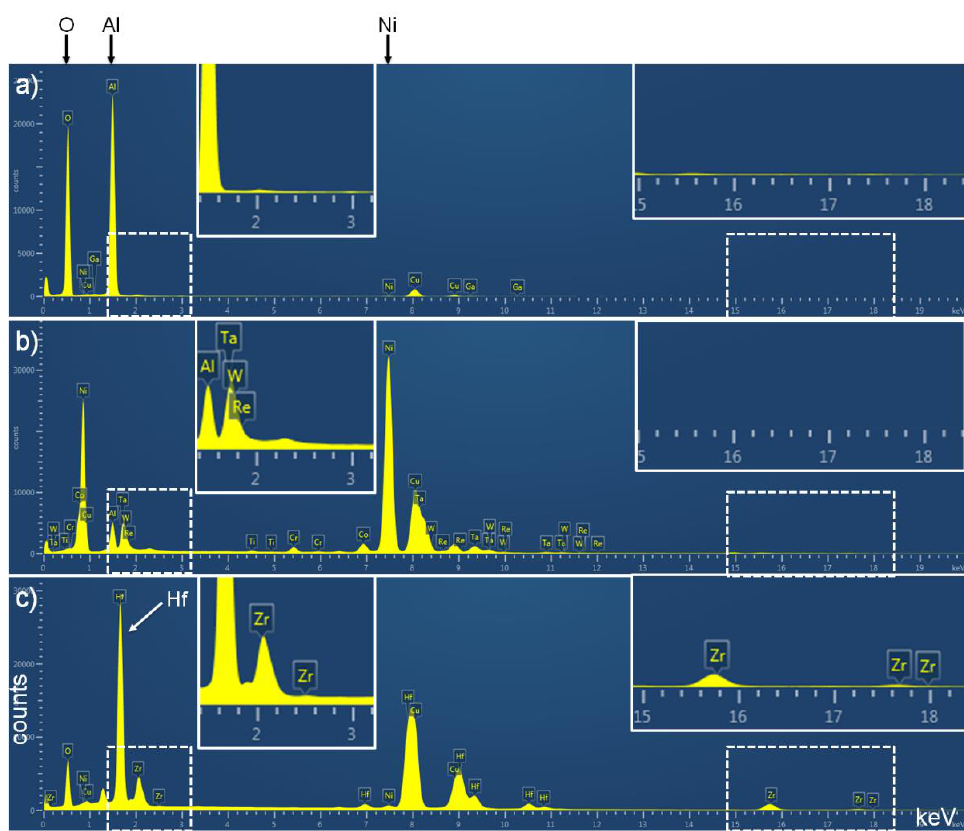
Figure 6. Representative STEM-EDX spectra acquired on aluminium oxide ( a ), a base material or small particles ( b ), and hafnium oxide ( c ). For clear visualisation of key energy ranges, two regions in a spectrum, respectively, were magnified and added as inserts.